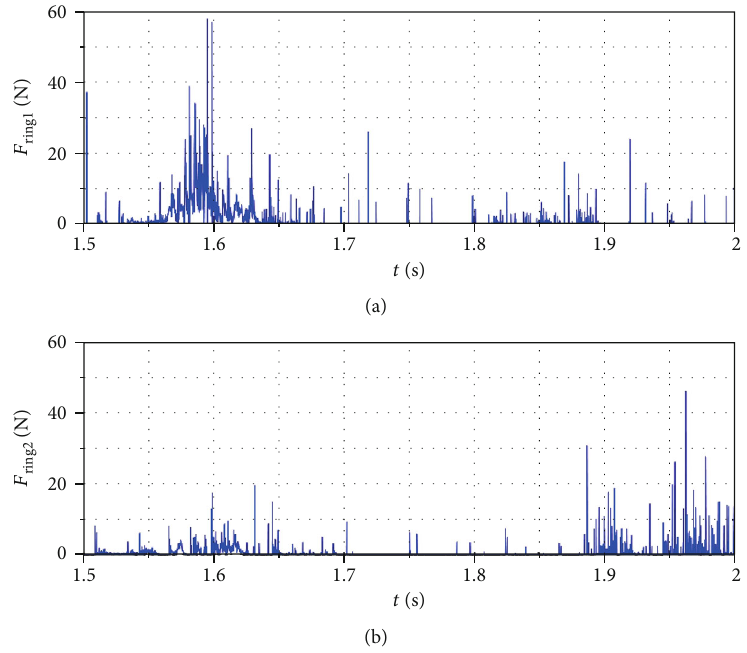
Figure 13: Contact force on rings 1 and